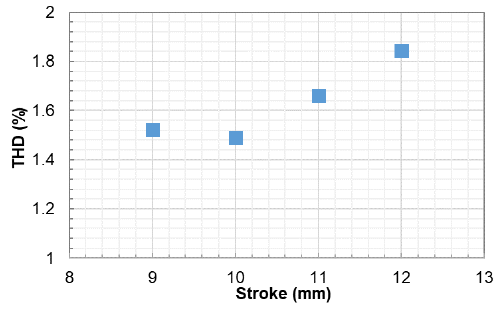
Figure 6. The THDs of measured voltages versus stroke.